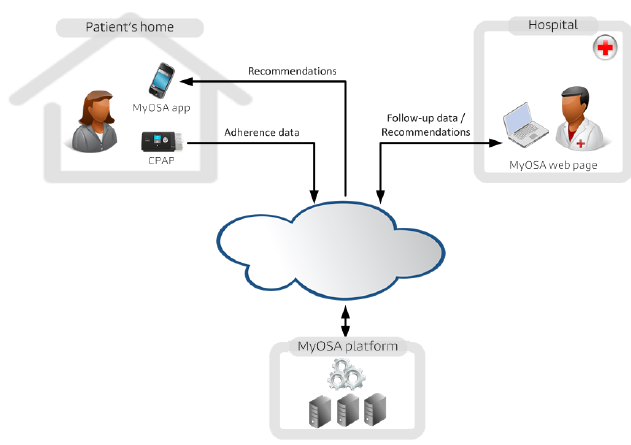
Figure 1. Overall view of the MyOSA